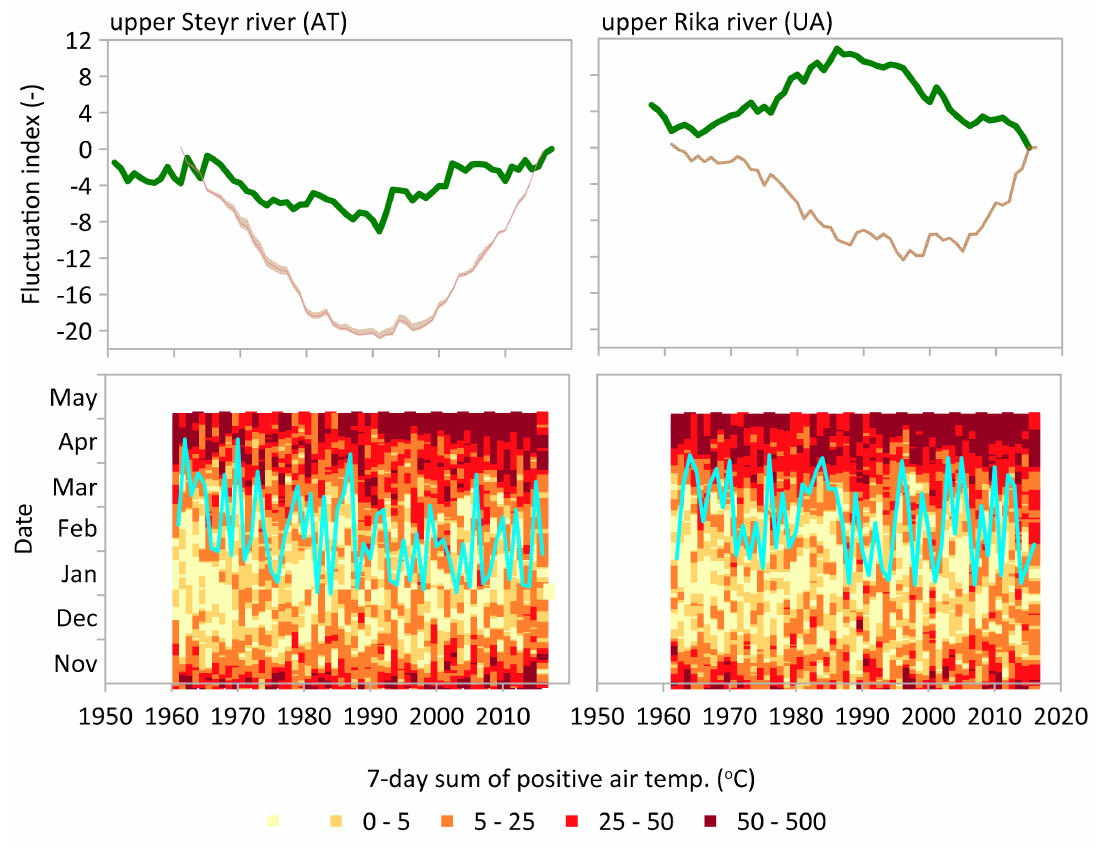
Figure 7. Fluctuations ( top panels) of the sum of positive air temperature and seasonality ( bottom panels) of the seven − day melt index in the upper Steyr and the upper Rika catchments. Variability in the sum of positive air temperature (brown band in left top panel) is plotted for all sub − catchments in the upper Steyr catchment and Mizhhiria station in the upper Rika River ( top right panel). The green line indicates the fluctuation index of the winter floods ( top panels). Bold lines ( bottom panels) represent the seasonality of the snowmelt index, i.e., the first full seven days in a year when surface air temperatures exceed 0 ◦ C.